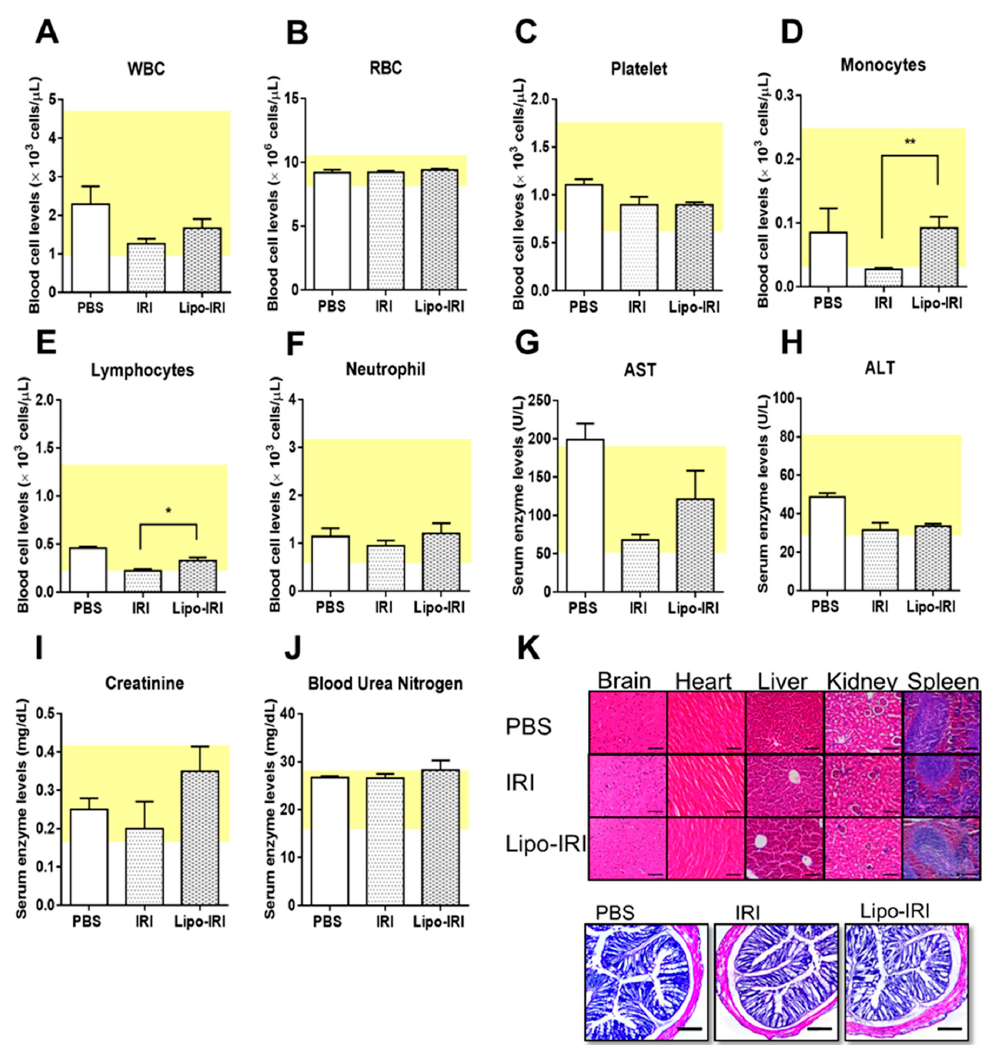
Figure 5. Evaluation of side effects in hematological and histological study. The mice were treated with either IRI or Lipo-IRI at 5 mg/kg twice weekly. The plasma and serum were harvested and analyzed. The hematology for ( A ) white blood cell (WBC), ( B ) red blood cell (RBC), ( C ) platelet, ( D ) monocyte, ( E ) lymphocyte, and ( F ) neutrophil are shown. The ( G ) aspartate aminotransferase (AST), ( H ) alanine aminotransferase (ALT), ( I ) creatinine, and ( J ) blood urea nitrogen levels were measured to assess the hepatotoxicity and nephrotoxicity. The data are presented as the mean ± SEM ( n = 3). The yellow box indicates the normal range. Compared to IRI, * p < 0.05. ( K ) The major organs were harvested for paraffin embedding, and the colon was frozen in optimal cutting temperature (OCT) compound after the end of the treatment. Tissue sections were stained with H&E for a histological analysis (Scale bars, 200 μ m).